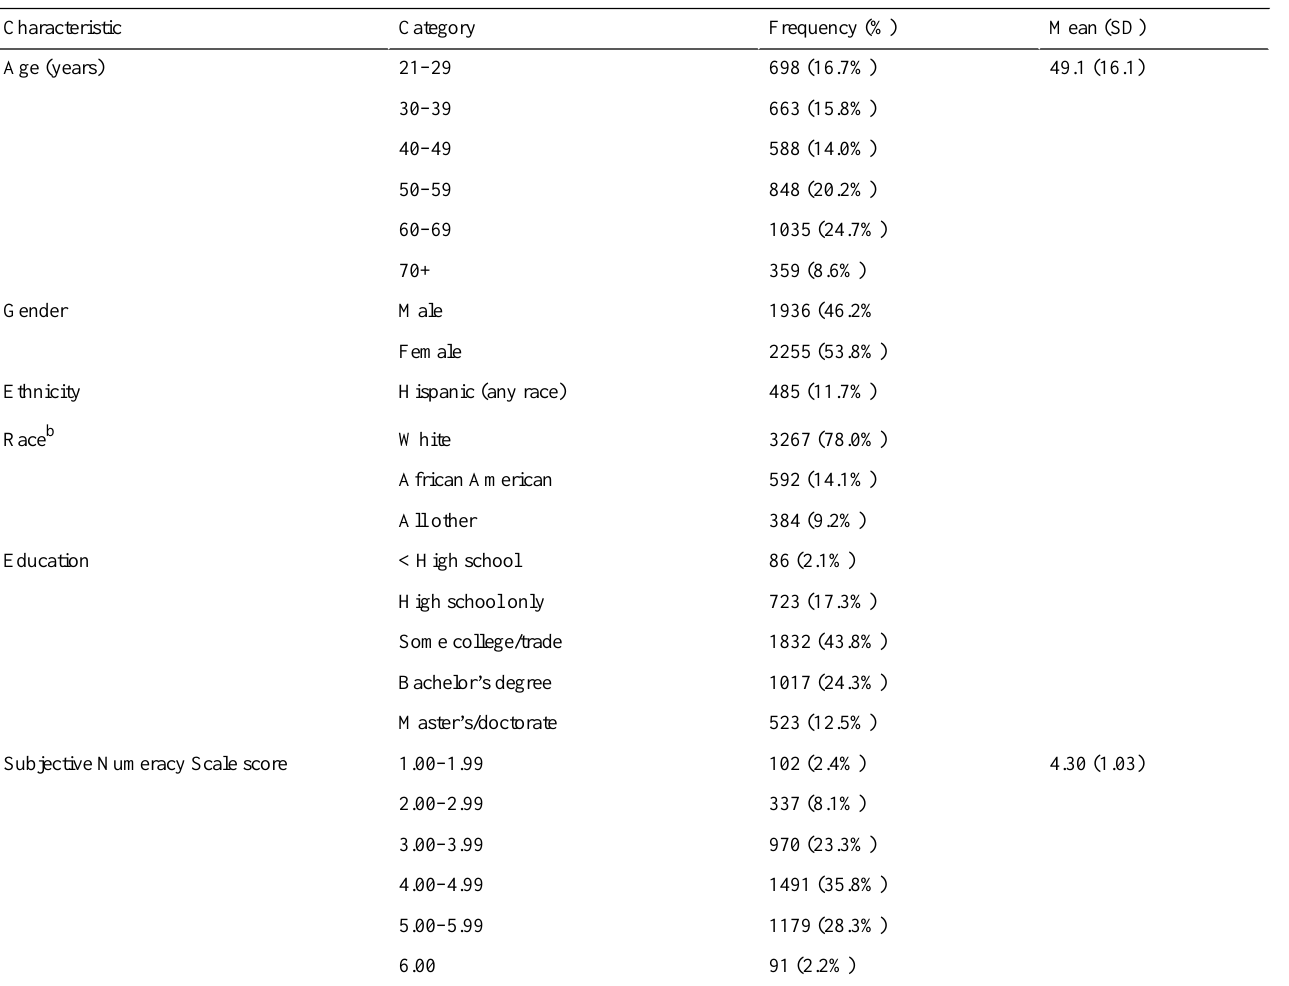
Table 2. Participant demographic characteristics (n = 4198) a